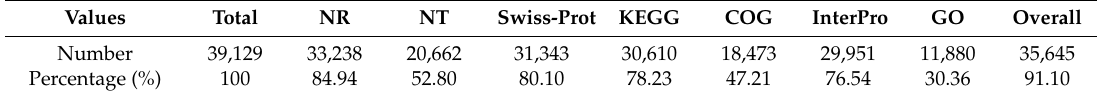
Table 4. Summary of functional annotation results.